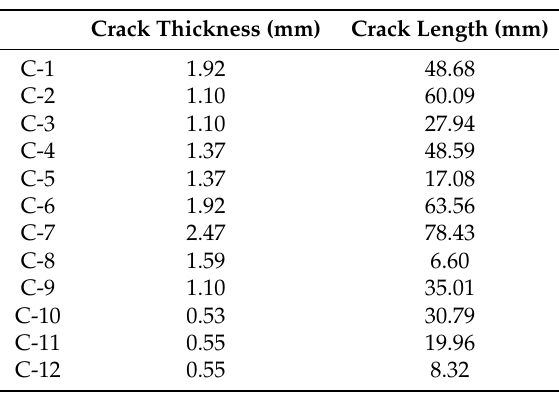
Figure 9. Crack quantification by using image processing. Table 2. Results of crack